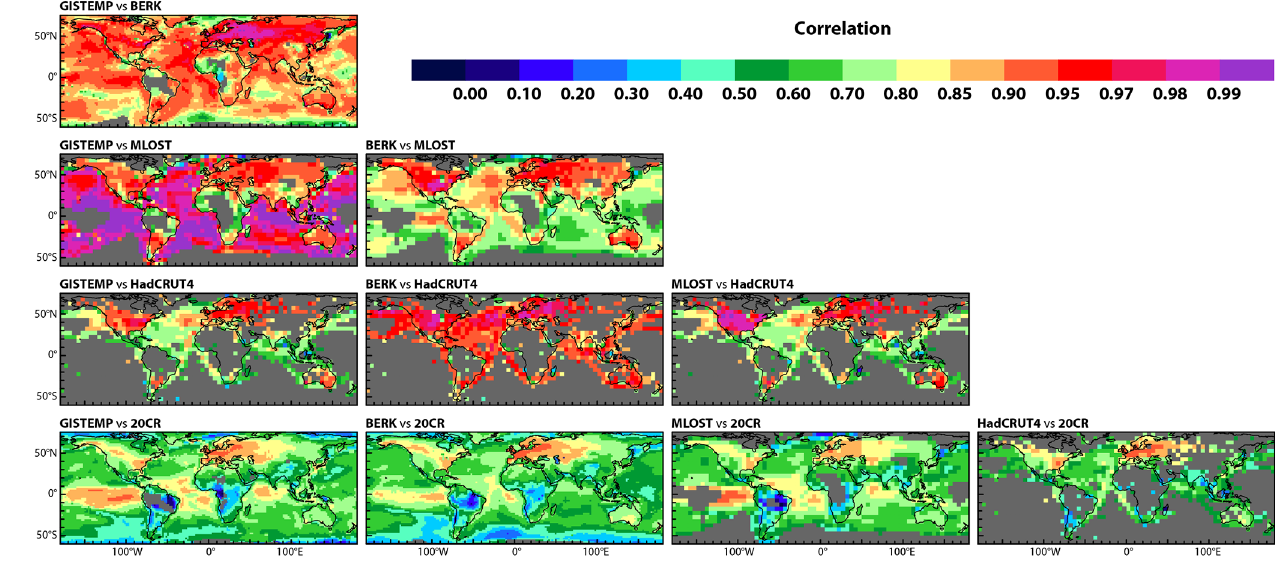
Figure 2. Pair-wise Pearson correlation coefficients between local monthly temperature anomaly series from different data sets for the 1901–2010 period. See Fig. S1 for correlations during the 1901–1955 and 1956–2010 sub-periods.